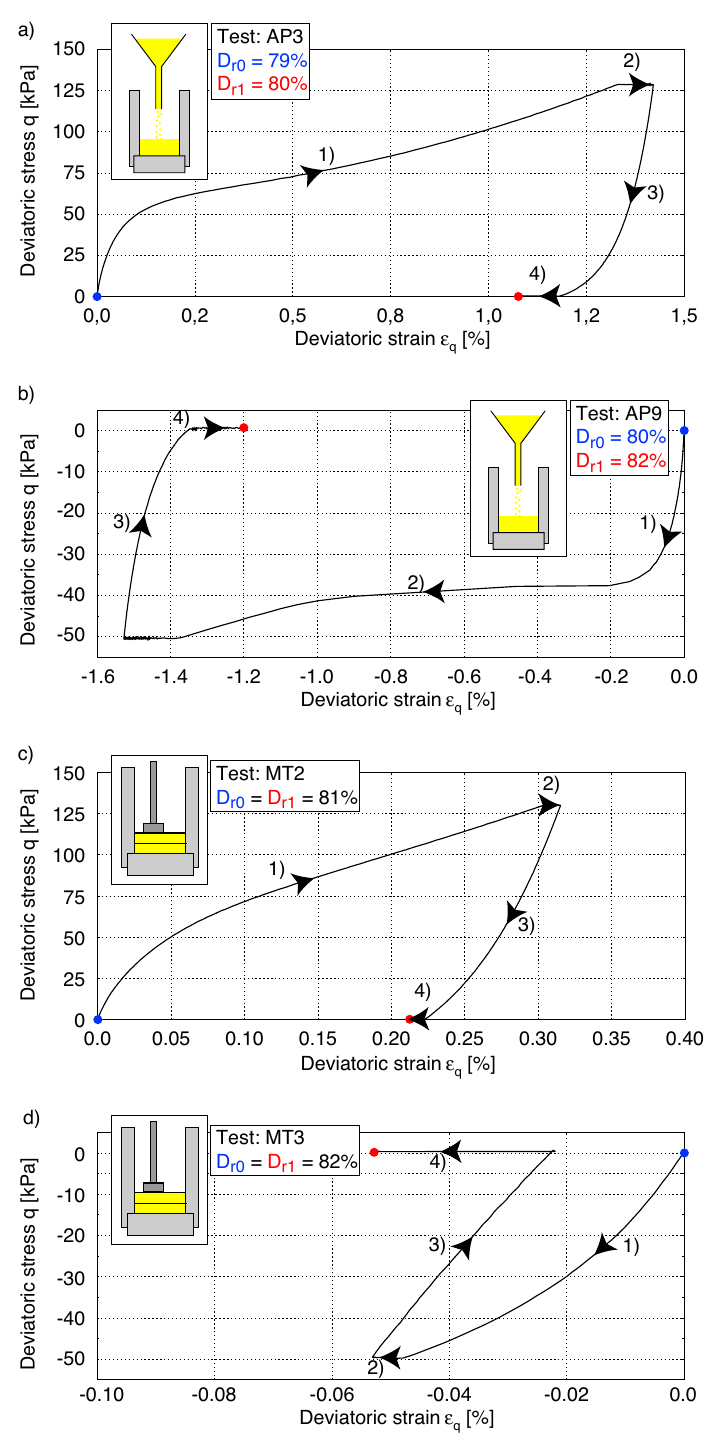
Figure 8. q – ε q diagrams during the preloading paths of tests AP3, AP9, MT2 and MT3 from the Figs. 6b,c and 7b,c.